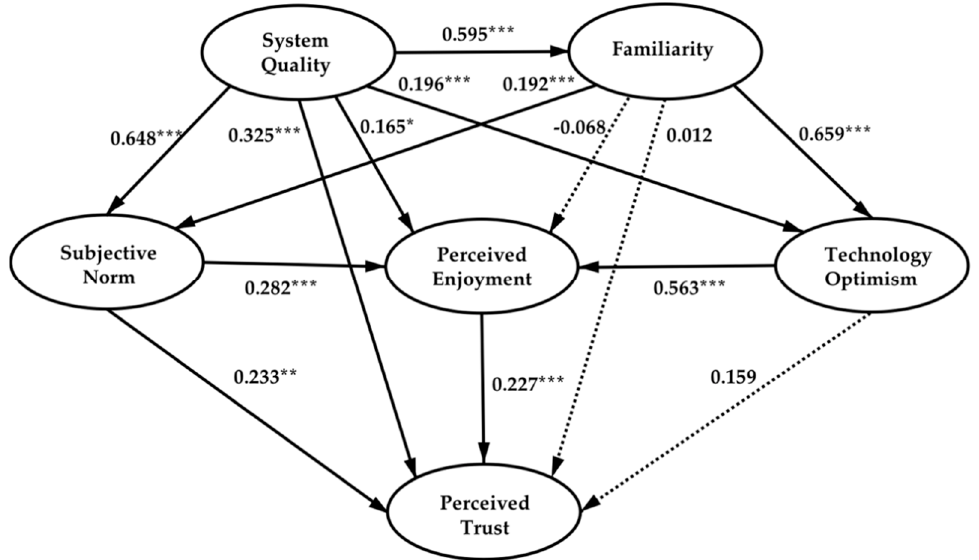
Figure 2. Path coefficients resulting from structural equation modeling (SEM). Note: * p < 0.1; ** p < 0.05; *** p < 0.01.